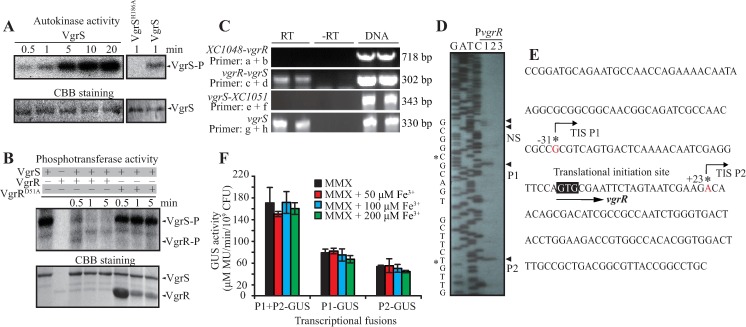
VgrR-VgrS is a two-component signaling system.(A) VgrS has autokinase activity. Inverted membrane vesicles of full-length VgrS and VgrSH186A recombinant proteins (5 μM) were incubated with 100 μM ATP containing 10 μCi [γ-32P]ATP. (B) VgrS transferred phosphoryl group to VgrR. VgrS (5 μM) was autophosphorylated as in (A) for 2 min. Twenty μM VgrR or 80 μM VgrRD51A proteins were added into the reaction, respectively. In both (A) and (B), the reaction was stopped by loading buffer before SDS-PAGE separation and autoradiography. The gel was stained by Coomassie brilliant blue (CBB) to check the amount of proteins (lower panels). Each experiment was repeated three times. (C) vgrR and vgrS constitute a bicistronic operon. RT-PCR was used to amplify cDNA. RT: amplification using cDNA transcribed from total RNA as template.–RT: negative control lacking reverse transcriptase during cDNA synthesis. DNA: amplification using bacterial DNA as template. Amplification of vgrS cDNA was used as a positive control. Location of the primers is shown in Fig 1A (upper panel). The assay was repeated three times. (D) Mapping the transcription initiation site (TIS) of the vgrR-vgrS operon. Primer extension using total RNA of X. campestris pv. campestris as the template. The G-A-T-C lanes show the dideoxy chain termination sequencing reaction in the same promoter region (note that the top of the ladder is blur for high GC content of the template). 1 and 2: vgrR mRNA was reverse transcribed at 42°C and 52°C, respectively, 3: △vgrR mRNA template (with primer binding site being deleted) was reverse transcribed at 42°C as negative control. TIS sites (P1 and P2) are shown as asterisks. NS: non-specific bands. The experiment was repeated independently twice. (E) Nucleotide sequence of the 5′ region upstream of vgrR. (F) GUS activity assay of promoters. GUS activity assays were conducted among all the recombinant bacterial strains with transcriptional fusions of P1-GUS, P2-GUS and P1+P2-GUS, respectively. Bacterial strains were induced in iron depleted (MMX) or iron replete (MMX plus Fe3+) conditions. Vertical bars represent the standard deviations (n = 3).